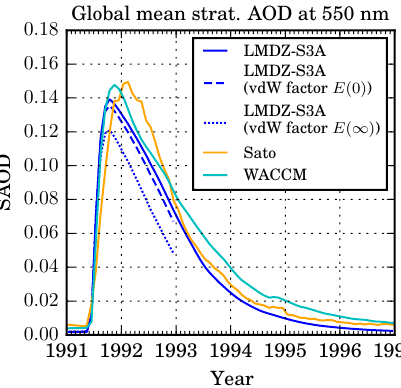
Figure 12. Stratospheric effective particle radius at Laramie, Wyoming (41 ◦ N, 105 ◦ W), as simulated by the LMDZ-S3A model and observed with optical particle counters (Deshler et al., 2003). The light blue (orange) line shows the model result for coagulation enhanced by the continuum regime van der Waals enhancement fac- tor E( 0 ) (the kinetic regime enhancement factor E( ∞ ) ).